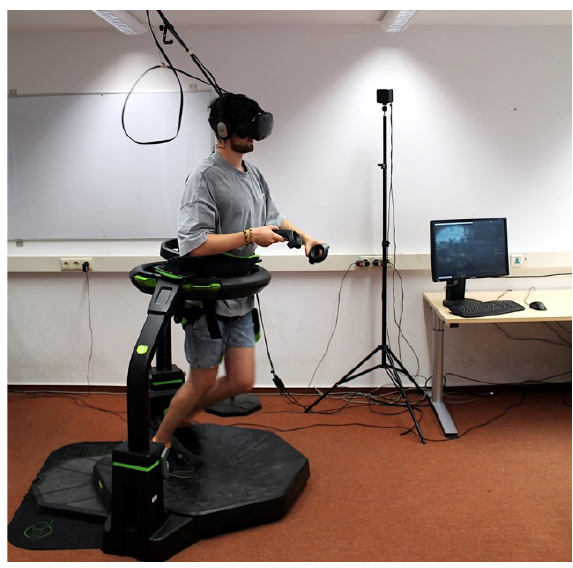
Figure 4. Laboratory setup of the Omni gaming experi- mental